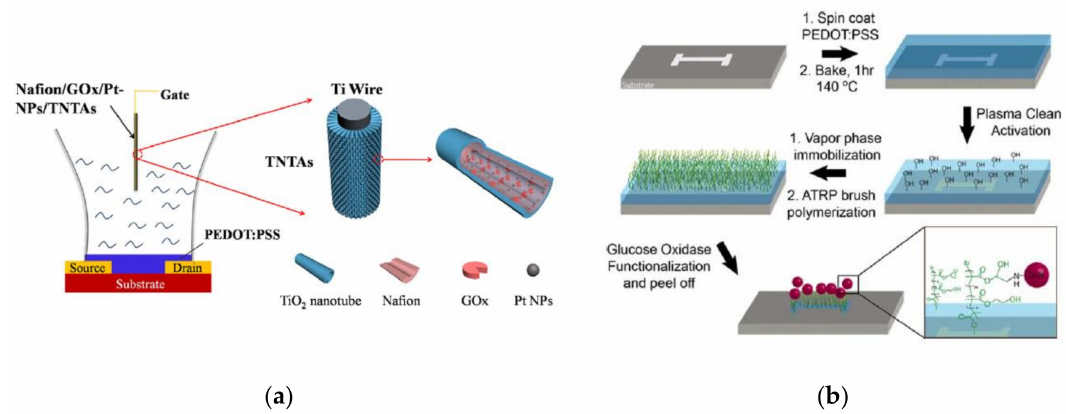
Figure 12. ( a ) The schematic diagram of the device structure of PEDOT:PSS based OECTglucose sensor using Nafion/GOx/Pt-NPs/TNTAs as a gate electrode. Reprinted from [127]. Copyright 2014, with permission from Elsevier. ( b ) PGMA:PHEMA mixed polymer brush and GOx fabrication. Reproduced from [129] with permission from John Wiley and Sons, Copyright ©